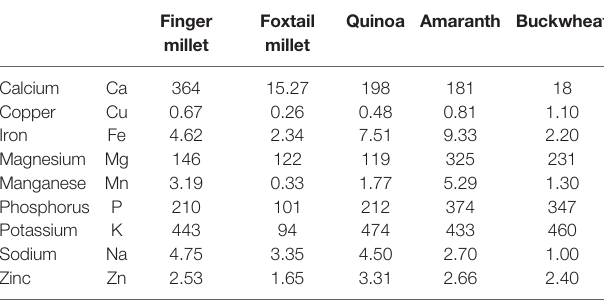
TABLE 2 | Mineral composition in grains (mg/100 g).